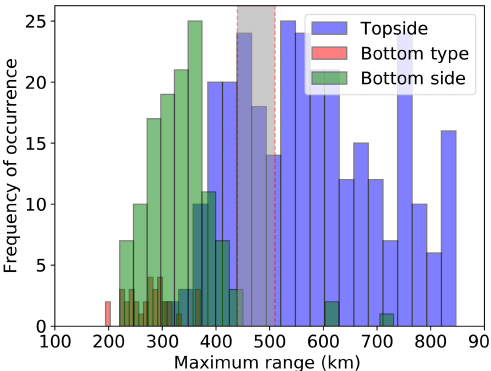
Figure 3. Frequency of occurrence of the maximum height achieved by the different types of ESFs observed by the JULIA radar for the years from 2014 to 2018. The grey region indicates the approximate altitude coverage of the Swarm satellites from 2014 to